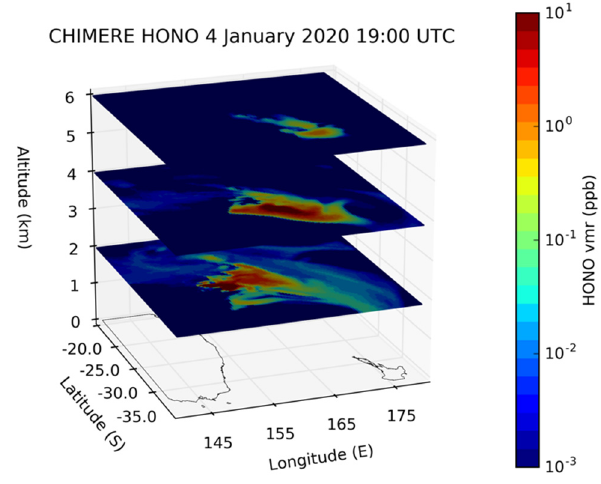
Figure 6. HONO vmrs simulated at 19:00 UTC, 4 January 2020 for different levels by CHIMERE.